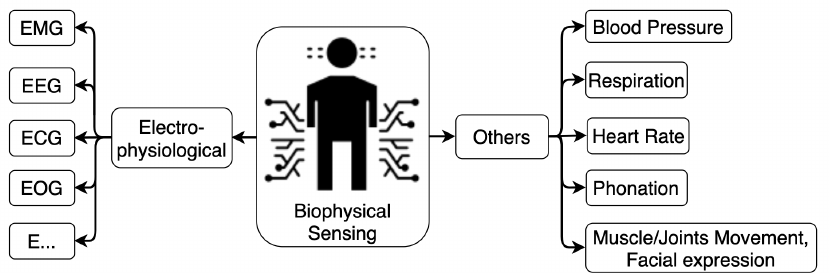
Figure 6. Physiological sensing modalities for